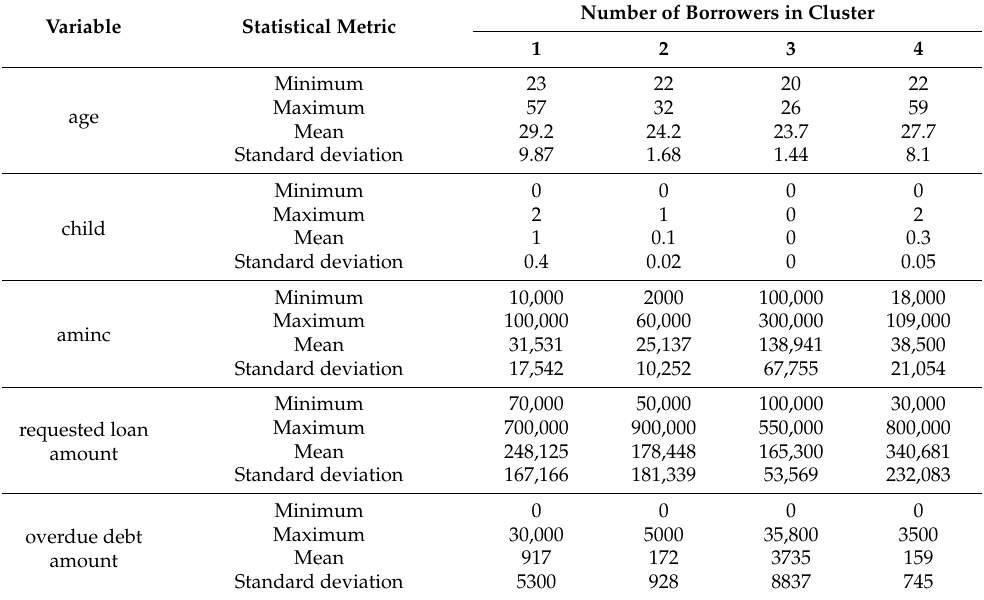
Table 6. Descriptive statistics for quantitative